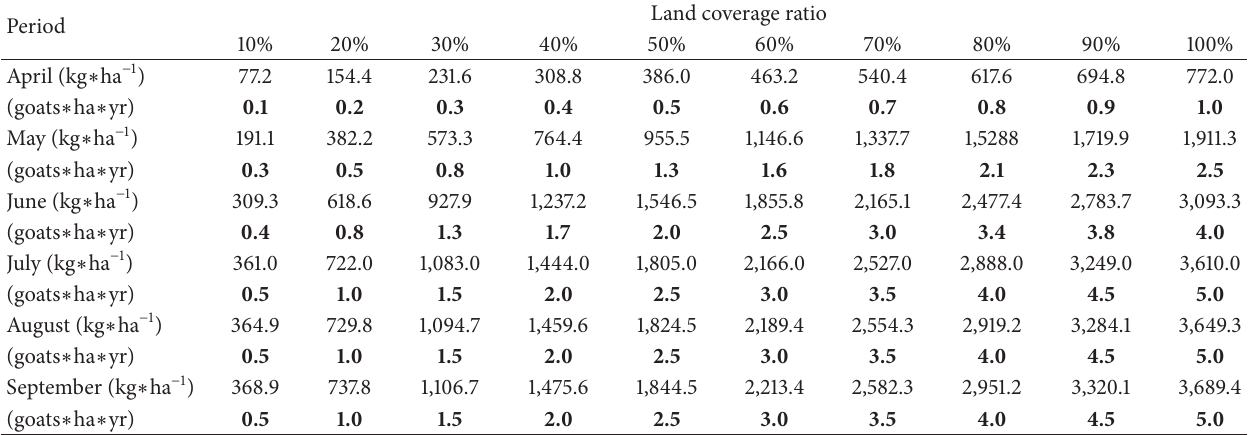
Table 3: Dry matter yields and optimal goat capacity of kermes oak in land coverage